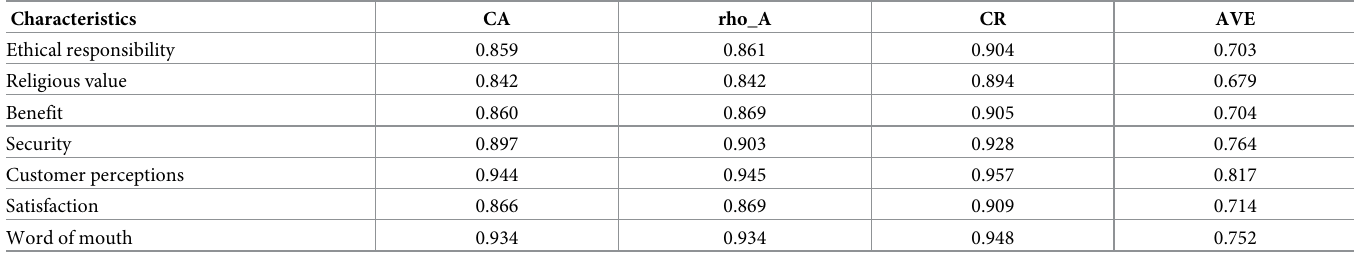
Table 3. Convergent validity.